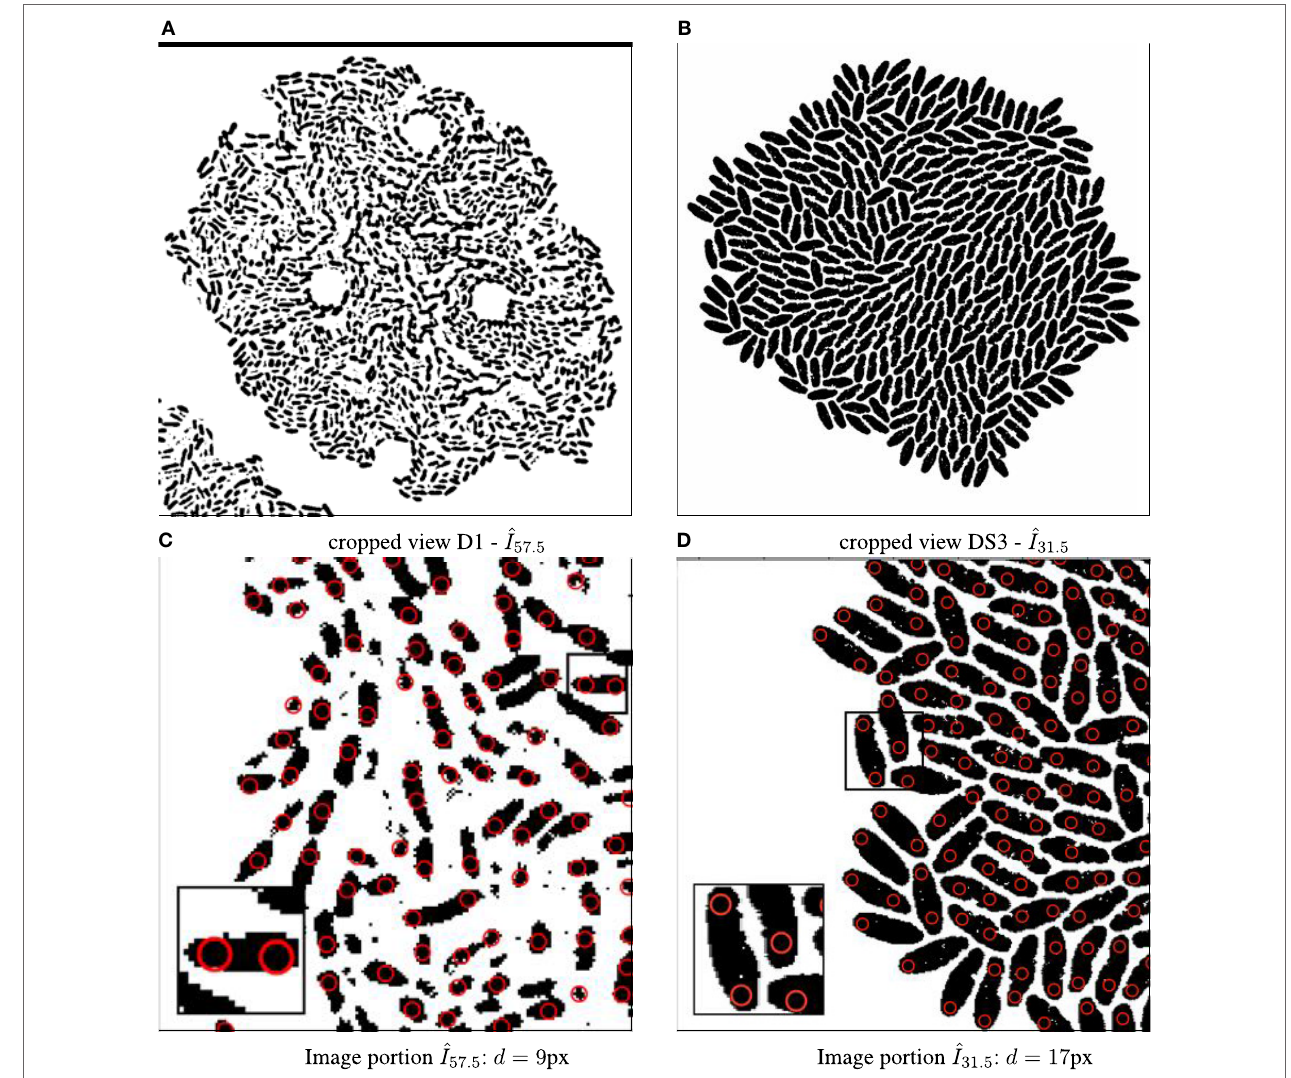
Figure 2 | Binary images annotated with computed particle positions (shown as red circles). (a) Original biomovie D1 binary image. (B) Simulated movie binary image. (c) Original biomovie crop of D1 showing 1–2 particles detected within each cell. A particle diameter value of d = 9 px yields no false negatives, and some false positives that will be eliminated in subsequent processing that exploits temporal coherence. (D) Simulated movie crop showing ~2 particles detected per cell, with a particle diameter d = 17 px.